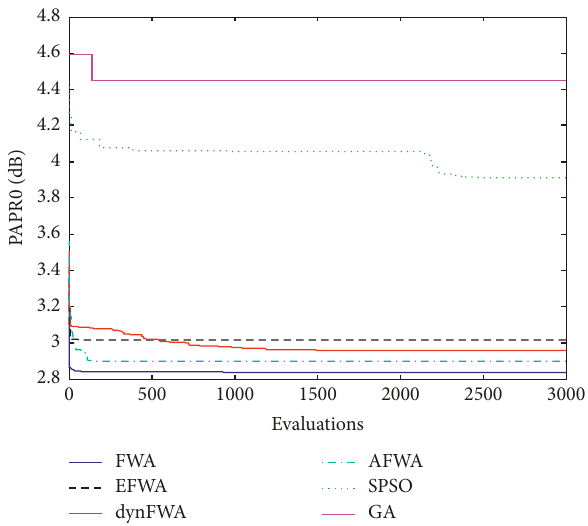
Figure 4: Convergence curves of the FWA, EFWA, dynFWA, AFWA, SPSO, and GA algorithms-based PTS for one symbol OFDM.